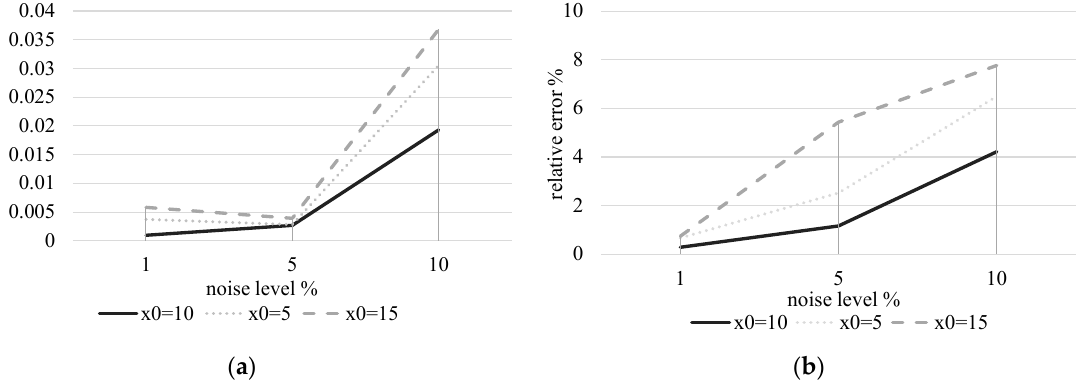
Figure 7. PINN’s relative error with different noise levels for ( a ) natural circular frequency; ( b ) damping ratio estimations.